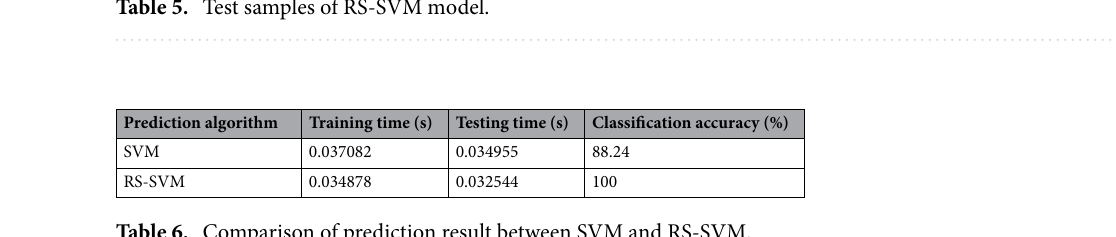
Table 5. Test samples of RS-SVM model.